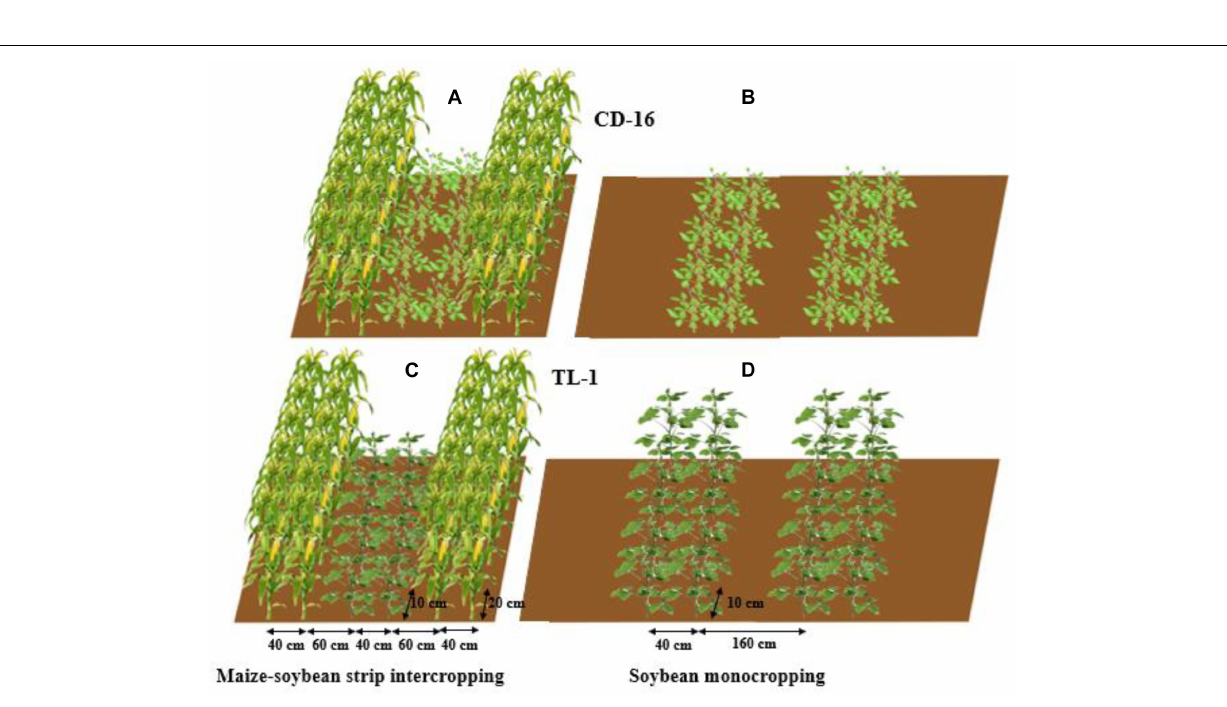
Frontiers in Plant Science |